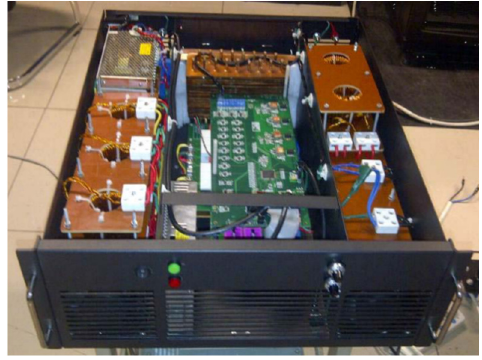
Figure 19. Prototype of the proposed